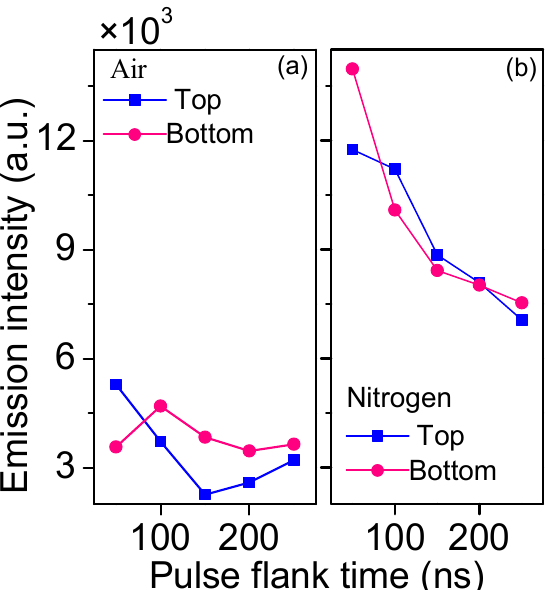
Figure 14. Effects of pulse rising and falling time on emission intensity of SPS of N 2 collected from the top and bottom of the reactor in ( a ) air and ( b ) nitrogen.